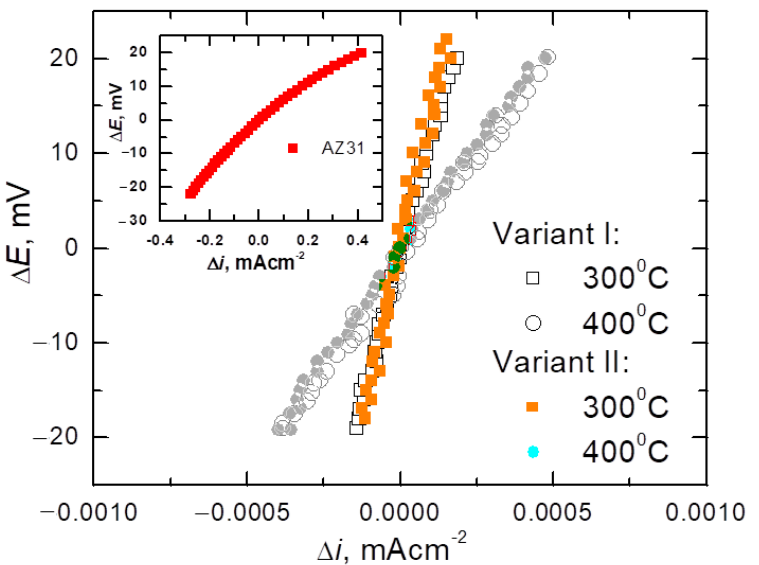
Figure 12. Measurements of linear polarization ∆ E = E − E corr = f(i outside ) of input material (AZ31) and bimetals after classic (variant I) or modified (variant II) rolling at the temperature of 300 ◦ C or 400 ◦ C.